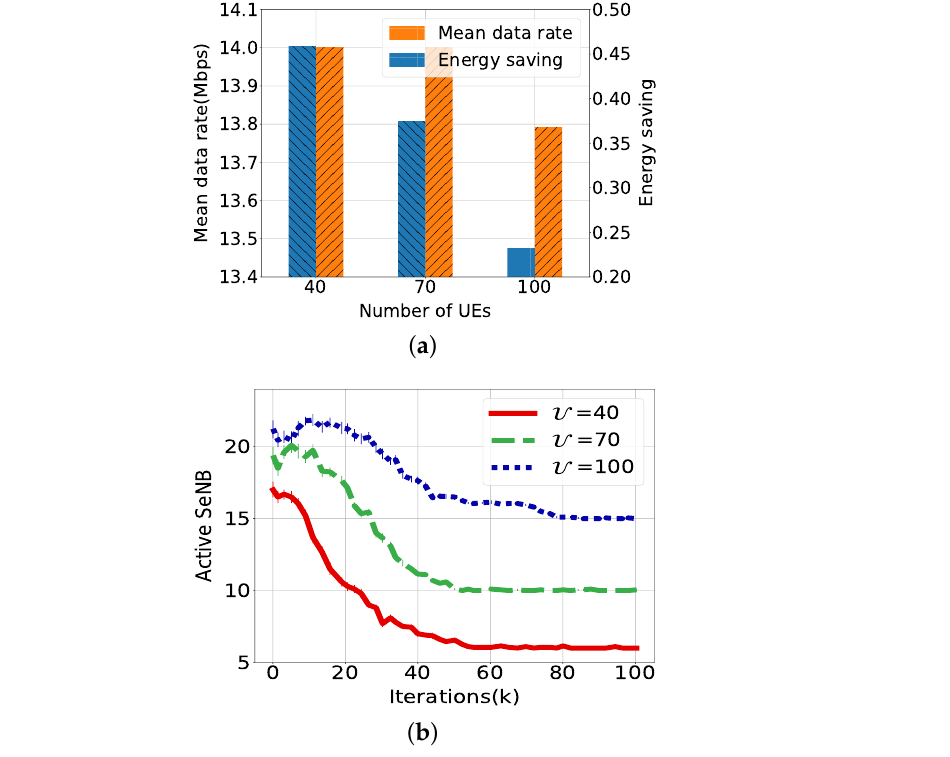
Figure 7. Performance evaluation of PDOLS according to the number of distributed UEs. ( a ) Average data rate per UE. ( b ) Number of active SeNBs.